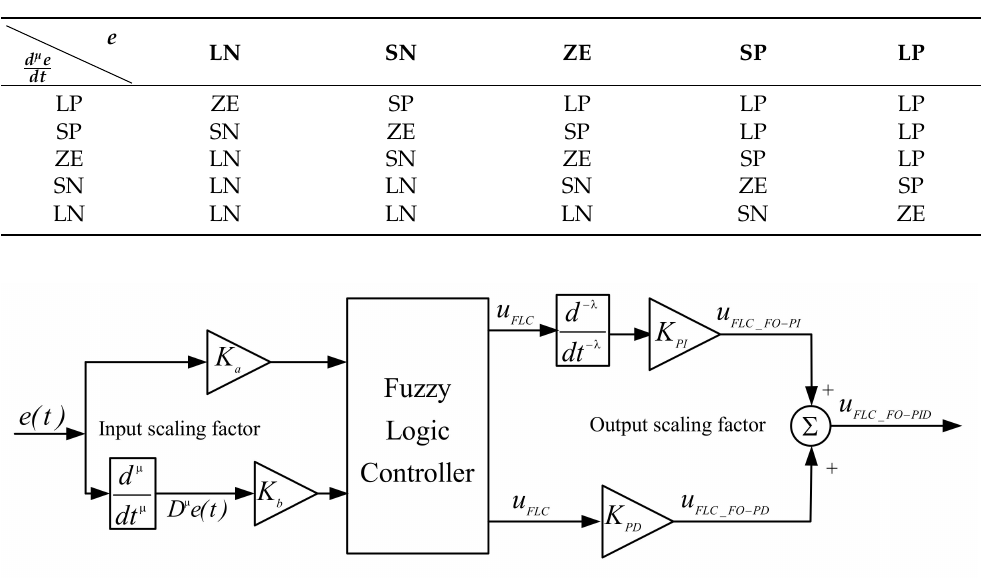
Figure 3. MFs for error, fractional derivative of error and FLC output. Table 2. Rule base for error, fractional rate of error and FLC output.